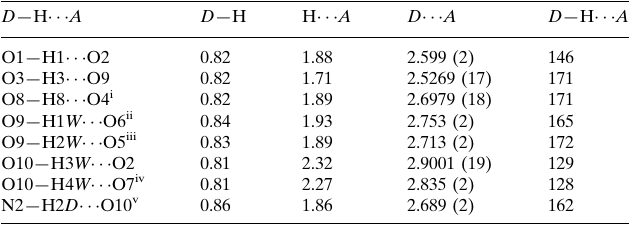
Hydrogen-bond geometry (A˚ , (cid:3)